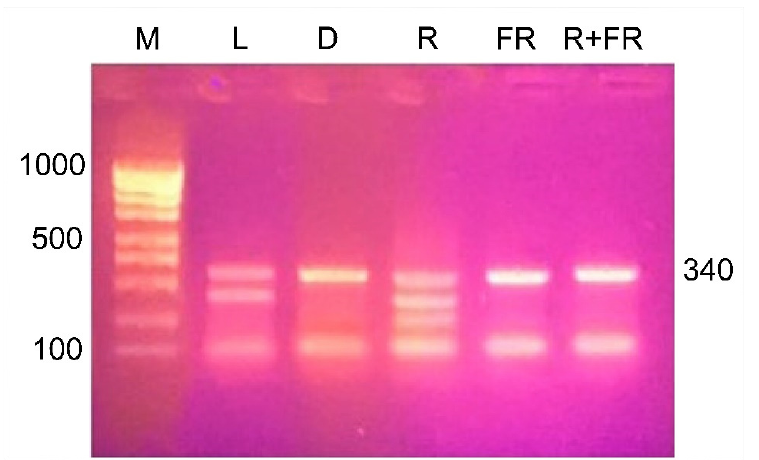
Figure 7. Restriction analysis of the nucleotide sequence with the restriction endonuclease MboI, specific for non-methylated adenine in the GATC site. M, DNA length markers; L, plants illuminated with white light; D, plants kept in darkness; R, plants illuminated with red (660 nm) light; FR, plants illuminated with far-red (730 nm) light; R+FR, plants illuminated with red (660 nm) followed by far-red (730 nm) light.